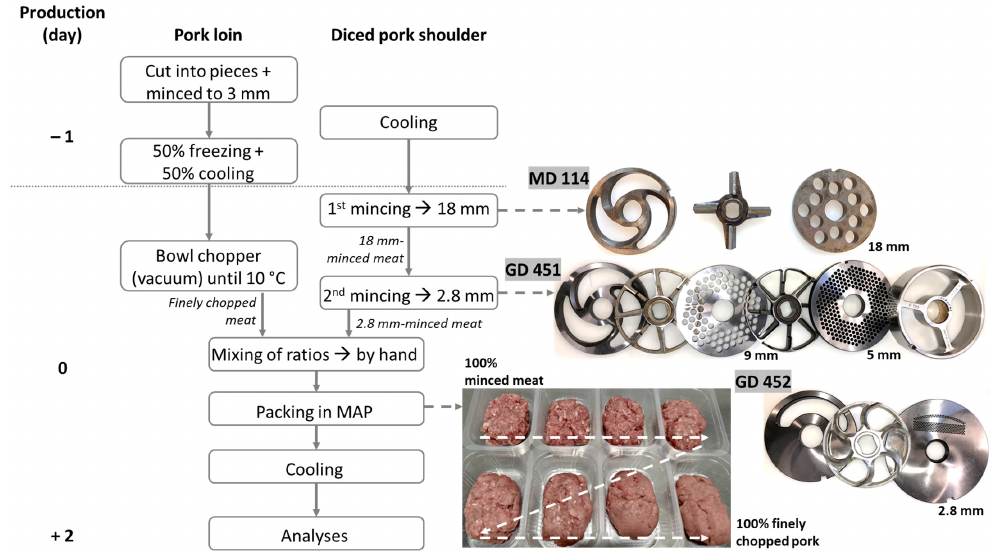
Figure 1. Flow chart of the finely chopped pork loin and minced pork production as well as photographs of the cutting devices of 1st and 2nd mincing of minced meat and produced minced meat mixtures (100%) with finely chopped pork added (0–100%). MAP means modified atmosphere packaging.